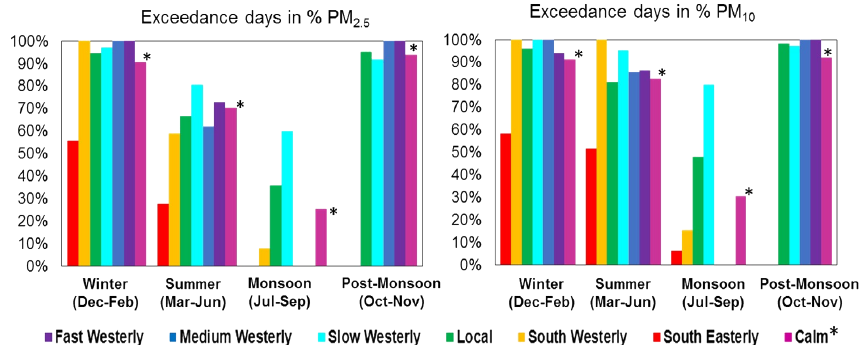
Figure 9. Percentage of days where the 24h average PM 10 and PM 2 . 5 mass loading (in µgm − 3 ) exceed the national ambient air quality standard for each air-mass cluster and season. ∗ For calm conditions, PM 2 . 5 or PM 10 were averaged for all times during a 24h interval that had WS < 1ms − 1 only. The fraction of exceedance days is calculated based on this average, and is not based on a genuine 24h average, as wind speeds do not remain low